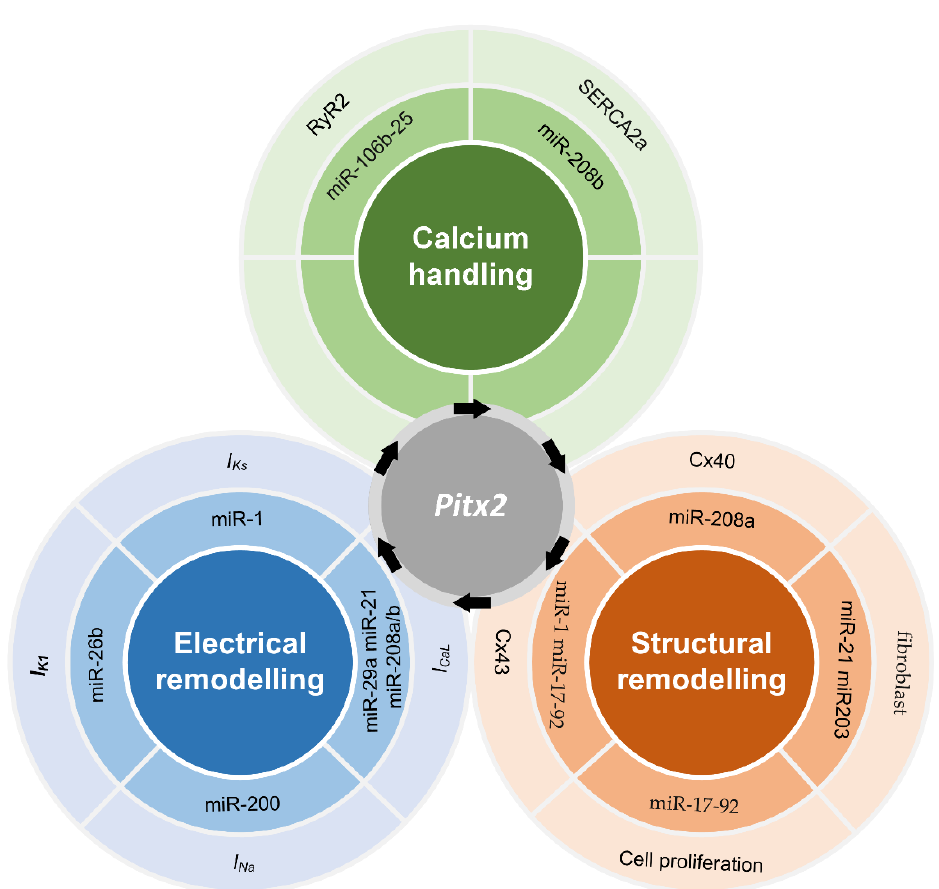
Figure 4. Remodelling linked impaired PITX2 to AF [65]. PITX2-induced remodelling includes electrical remodelling, structural remodelling and calcium handling. miR-26b, miR-200, miR-1, miR-21, miR-29a and miR-208a/b may regulate I K1 , I Ks , I Na and I CaL , contributing to PITX2-induced electrical remodelling. Changes in Cx43, Cx40, fibroblast and cell proliferation due to modulations of miR-208a, miR-21, miR-203, miR-17-92 and miR-1 contribute to PITX2-induced structural remodelling. In addition, abnormalities in calcium handling may arise from the regulation effects of miR-106b-25 and miR-208b on RyR2 and Serca2a, respectively.